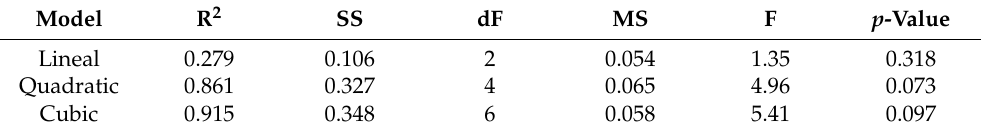
Table A1. F-test to choose the Eg model.